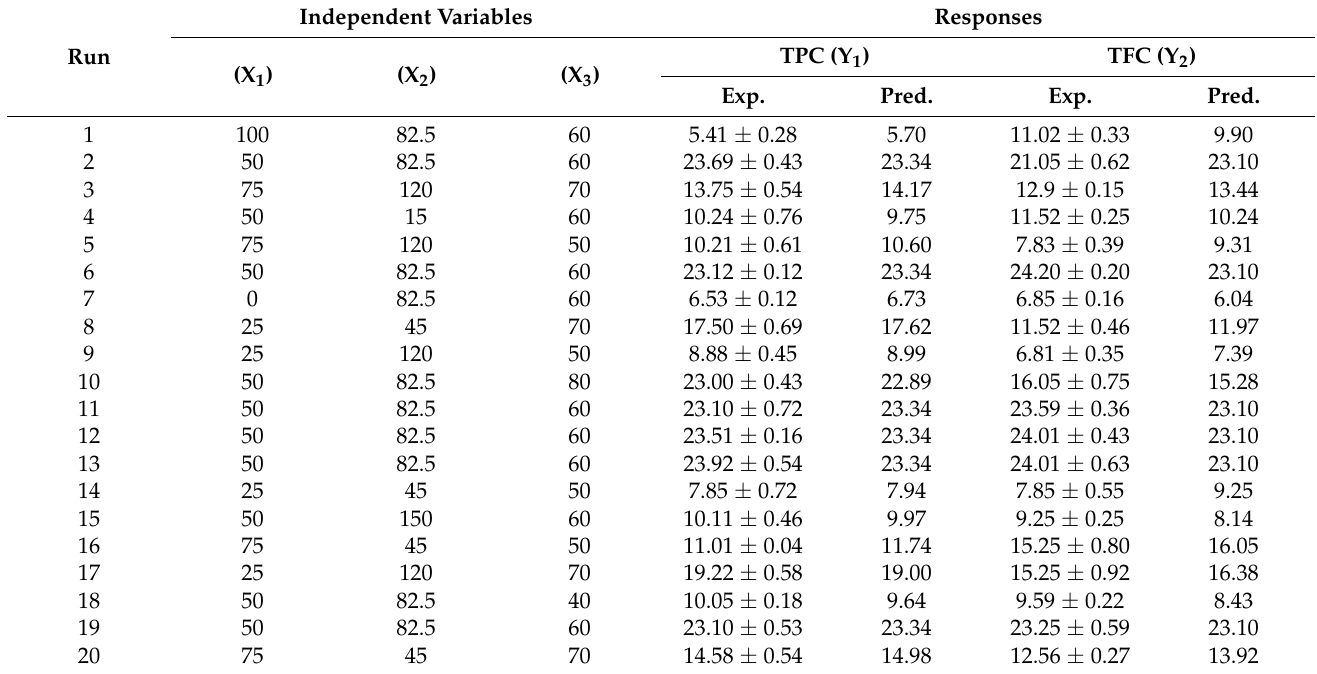
Table 1. Central composite design (CCD) for independent variables and corresponding response values (experimental).